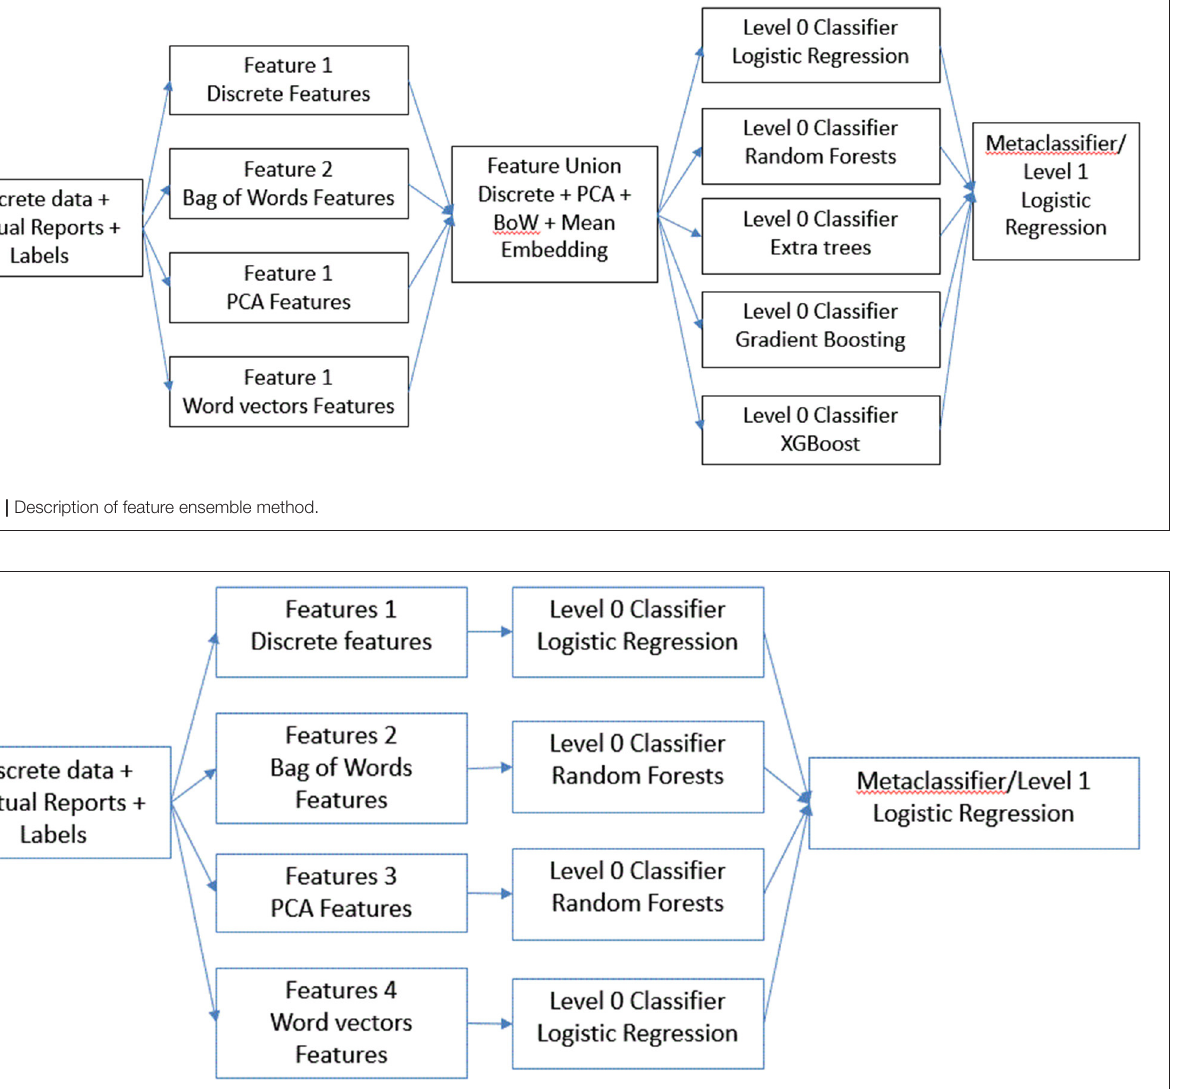
FIGURE 2 | Description of classifier ensemble